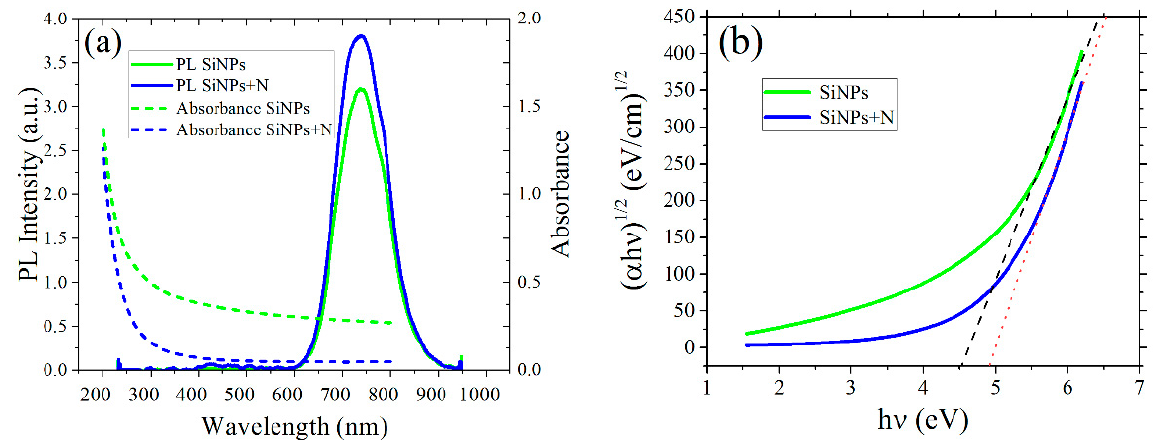
Figure 1. ( a ) Panoramic TEM micrograph of SiNPs embedded in SiO 2 . ( b ) Histogram showing the size distribution of the SiNPs.